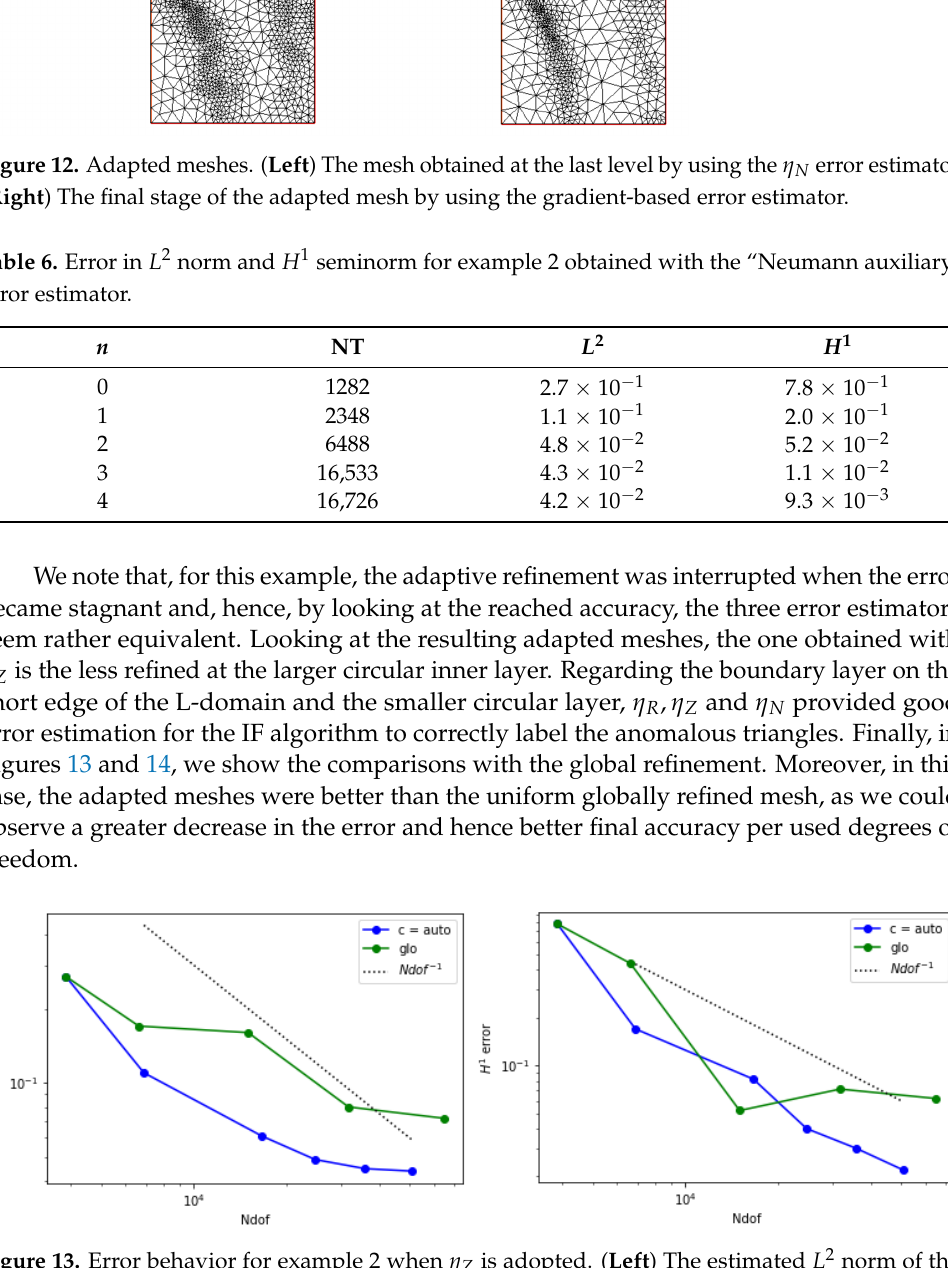
Figure 13. Error behavior for example 2 when η Z is adopted. ( Left ) The estimated L 2 norm of the error is displayed. ( Right ) The estimated H 1 seminorm is